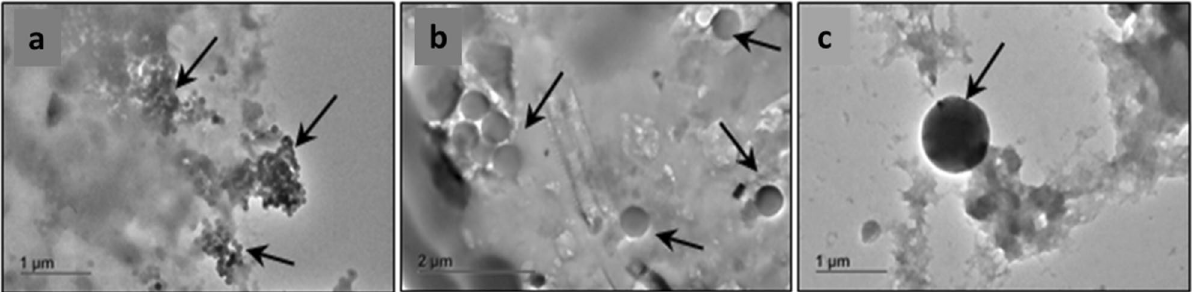
Figure 4. TEM images of the pNP recovered with the method described in this paper from the mussels’ experiments for ( a ) 100 nm PS pNP ( b ) 500 nm PS pNP ( c ) 1000 nm PS pNP.